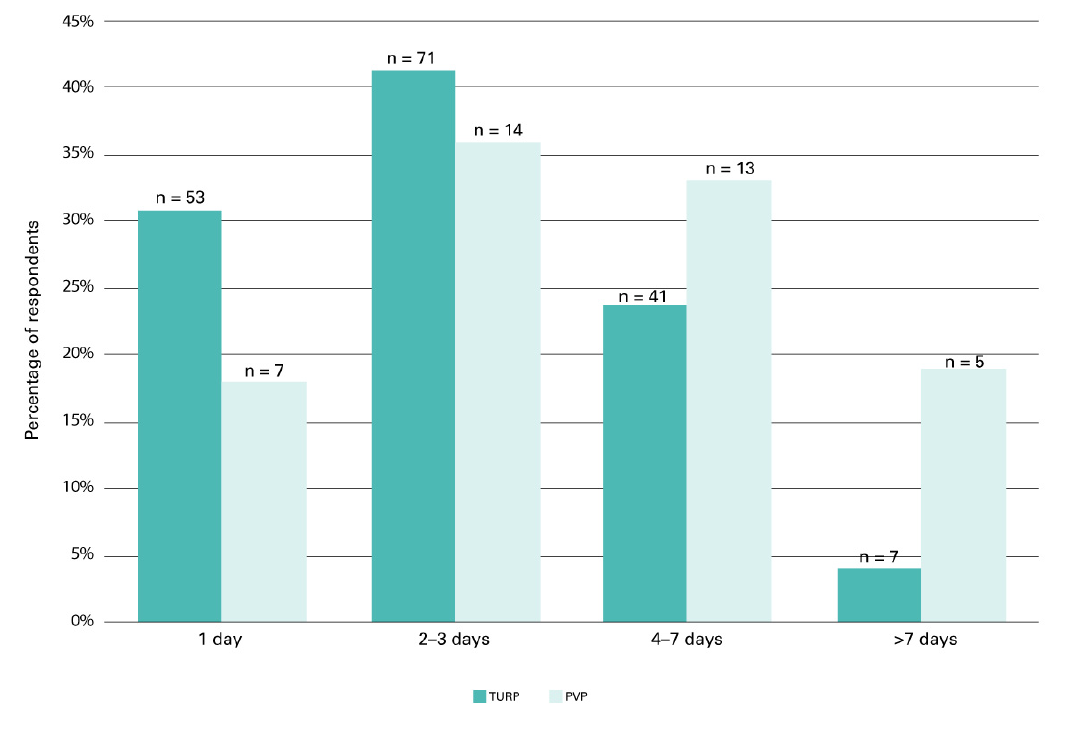
Figure 3: Prolonged postoperative antimicrobial prophylaxis. Overall, 60% (172/286) and 65% (39/60) of urologists extended antimicro- bial prophylaxis after transurethral resection of the prostate (TURP) and photoselective vaporisation of the prostate (PVP). Prophylaxis was predominantly given for an additional 2–3 days (TURP 41%, 71/172; PVP 36%,